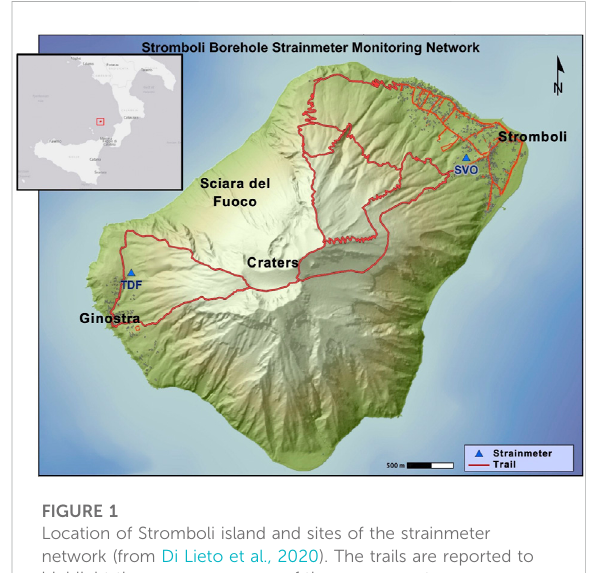
FIGURE 1 Location of Stromboli island and sites of the strainmeter network (from Di Lieto et al., 2020). The trails are reported to highlight the scarce presence of the escape